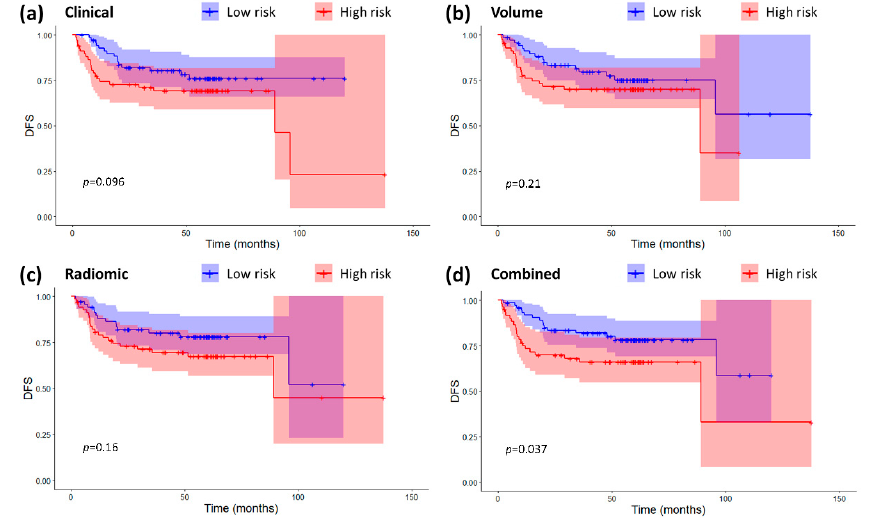
Figure 2. Kaplan-Meier curves and confidence intervals for disease-free survival (DFS) in the high and low risk groups as defined by the four prognostic models. ( a ) Clinical model. ( b ) Volume-based model. ( c ) Radiomic model. ( d ) Combined radiomic-clinical model. The p -values for the log-rank. tests are also displayed on the plots. Crosses represent censored data.